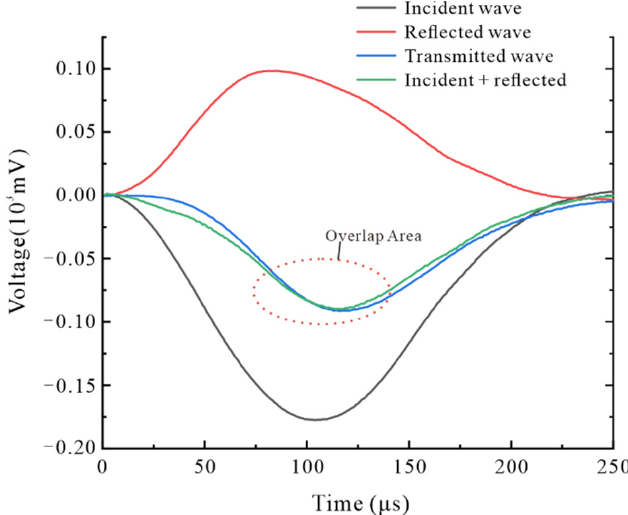
Figure 4. Stress balance diagram.